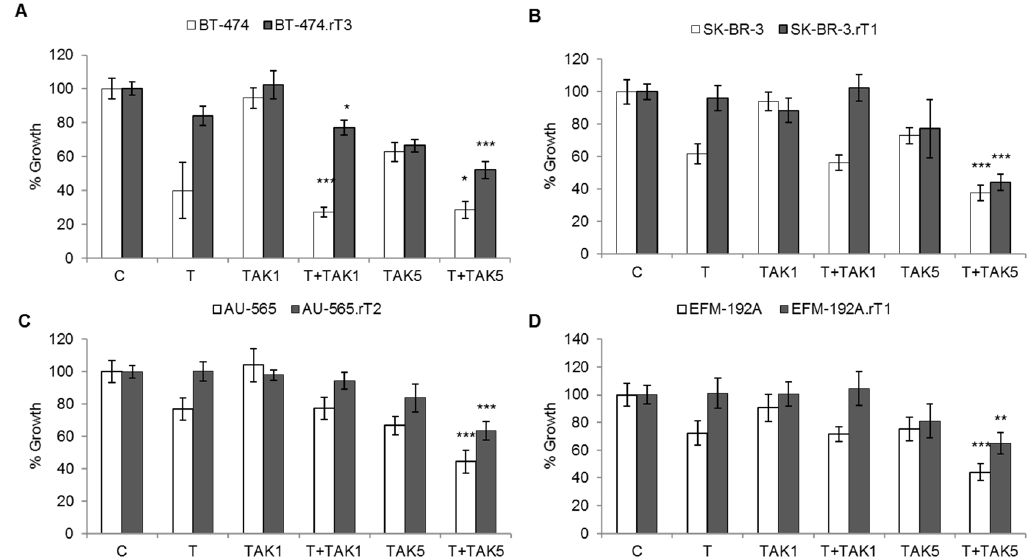
Figure 2. Decrease in mTOR activation status by TAK-228 affects trastuzumab sensitivity. Sensitive and trastuzumab- resistant cells were treated for seven days with DMSO, 15 µ g/mL trastuzumab (T), 1 or 5 nM TAK-228 (TAK), or a combination of 15 µ g/mL trastuzumab plus 1 or 5 nM TAK-228. Viable cells were then counted by trypan blue exclusion. Viability is presented as a percentage of the DMSO-treated control vector group. Error bars represent standard deviation between replicates ( n ≥ 3). * denotes p ≤ 0.05, ** denotes p ≤ 0.01 and *** denotes p ≤ 0.001. ( A ) BT-474 sensitive (BT474) and trastuzumab-resistant (BT-474.rT3) cells. ( B ) SK-BR-3 sensitive (SK-BR-3) and trastuzumab-resistant (SK-BR-3.rT1) cells. ( C ) AU-565 sensitive (AU565) and trastuzumab-resistant (AU-565.rT2) cells. ( D ) EFM-192A sensitive (EFM-192A) and trastuzumab-resistant (EFM-192A.rT1) cells.